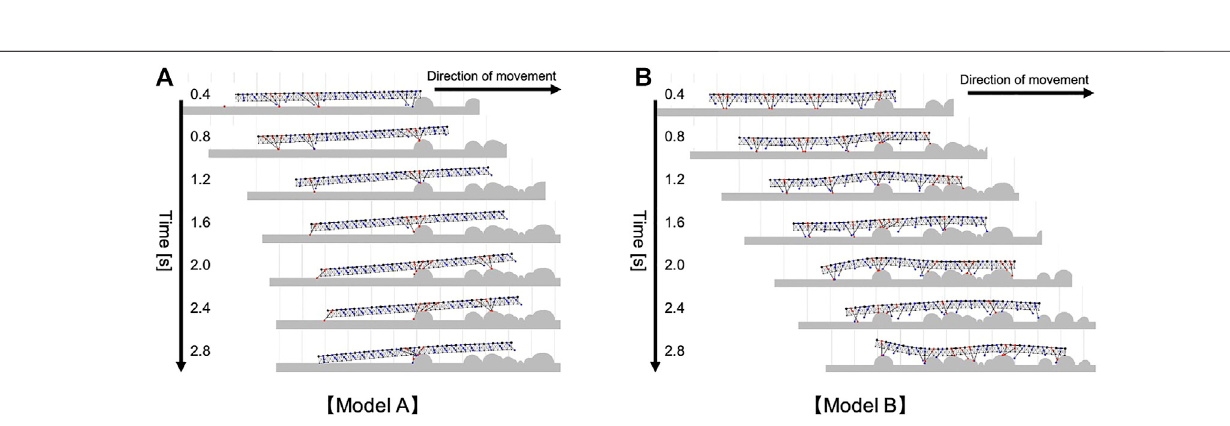
Frontiers in Robotics and AI |